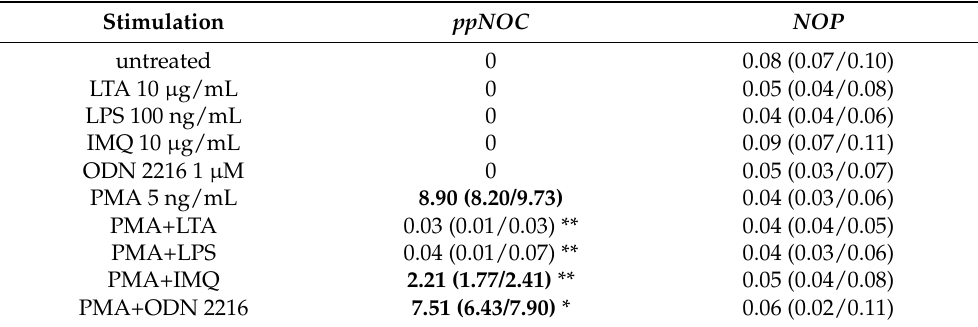
Table 2. Effects of TLR agonists on the regulation of ppNOC and NOP mRNA expression by PMA in THP-1 cells.